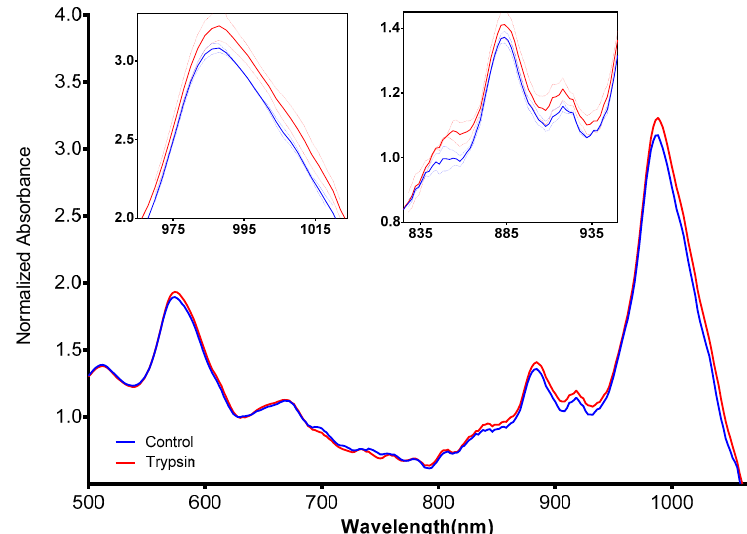
Figure 6. UV–Vis absorption spectra of HexCoil-Ala-encapsulated (6,5) SWCNTs before (blue) and after (red) incubation with 20 µg/mL trypsin. Left insert presents an enlarged 835–935 nm part of the spectrum, right insert the 975–1015 nm. Dashed lines represent SD, n = 4.